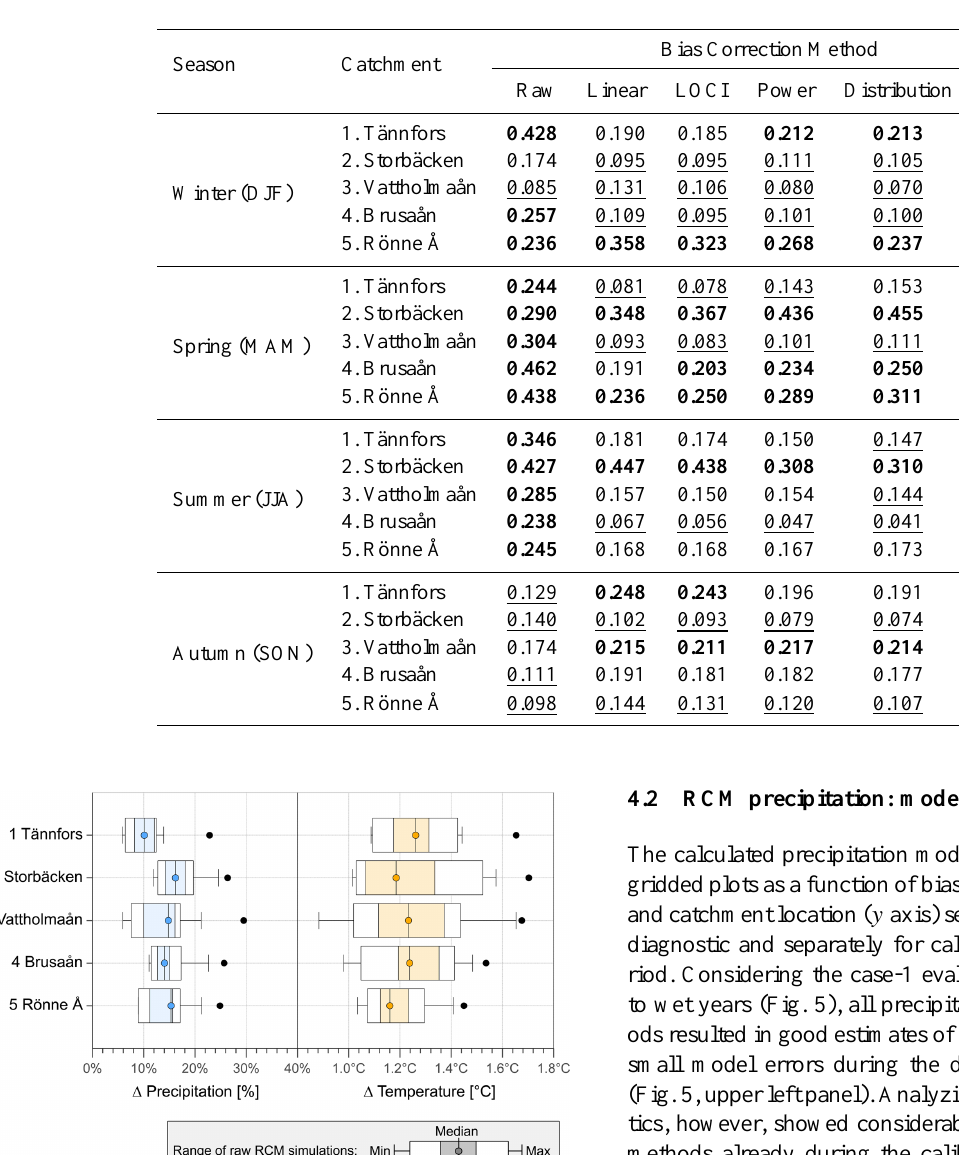
Table 6. Mean absolute error (MAE) of seasonally averaged precipitation [mmd − 1 ] of differently corrected ERA40-driven RCM simulations compared to observed seasonally averaged precipitation for case-1 evaluation. Larger MAE values are shown in bold, medium MAE values appear in regular font and smaller MAE values are underlined.